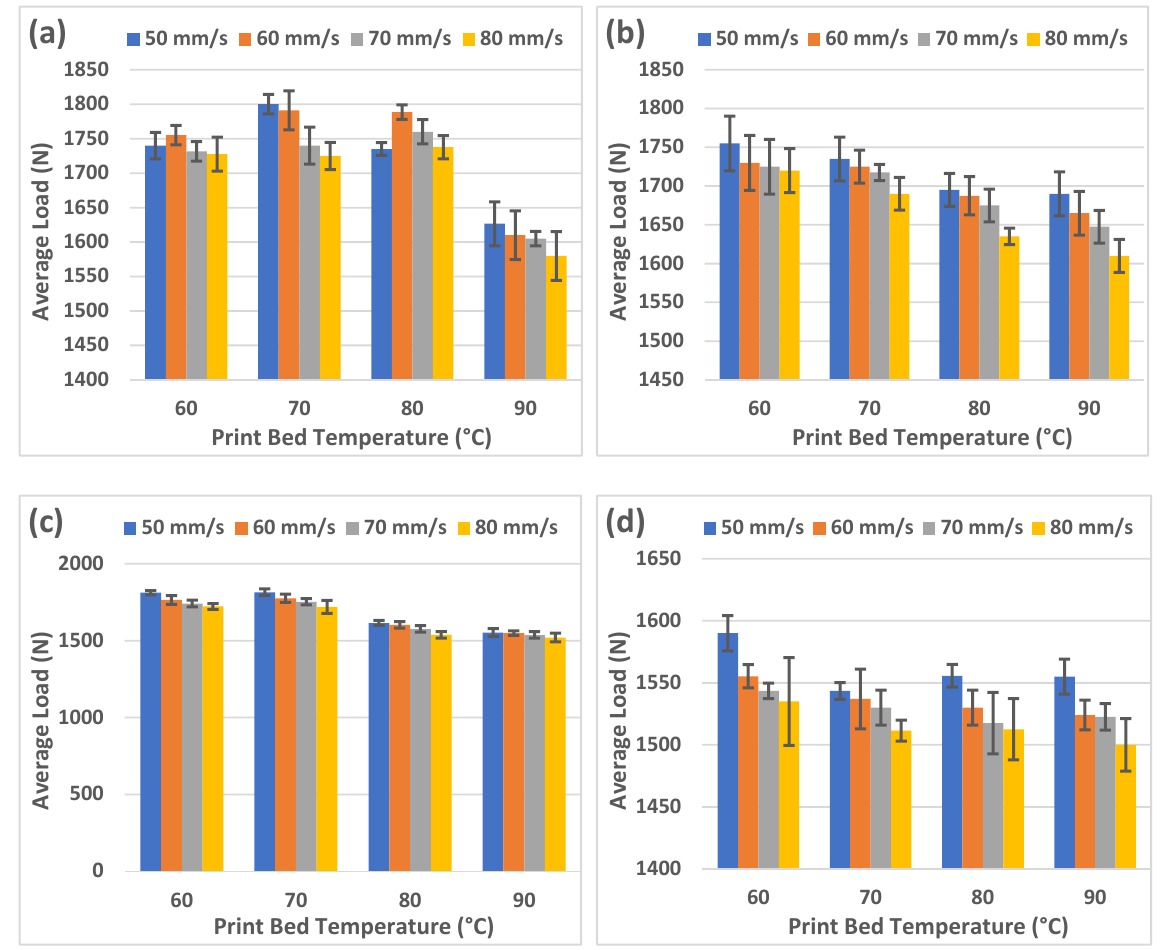
Figure 4. Results from tensile testing at different nozzle temperatures: ( a ) 180 °C; ( b ) 190 °C; ( c ) 200 °C; ( d ) 210 °C.